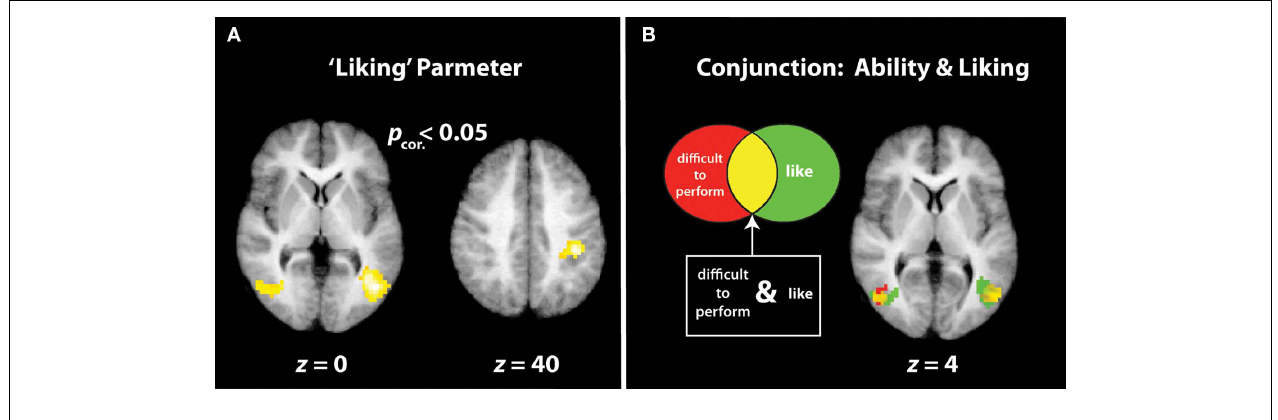
movement would be to reproduce (activations in red) and regions that are more active the more participants like an observed movement [same activations as those illustrated in (A) ; in green].Voxels of overlap between the two parametric contrasts are illustrated in yellow.